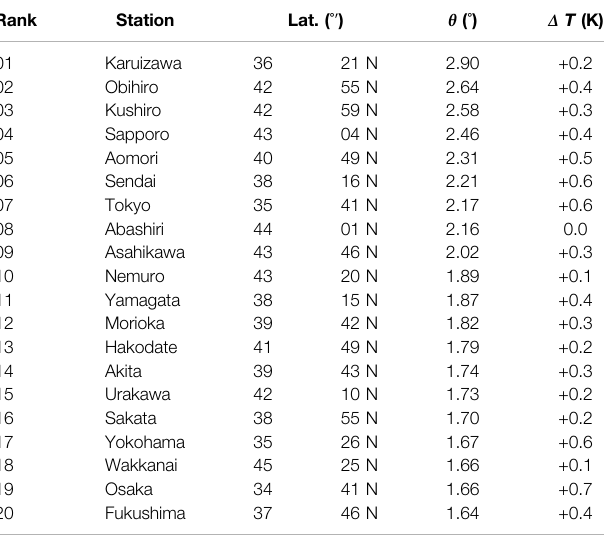
TABLE4A| Top-twentyJapanesestationsintheintersectingangleofthemonthly precipitations from Period I (from 1931 to 1960) to Period II (from 1951 to 1980).